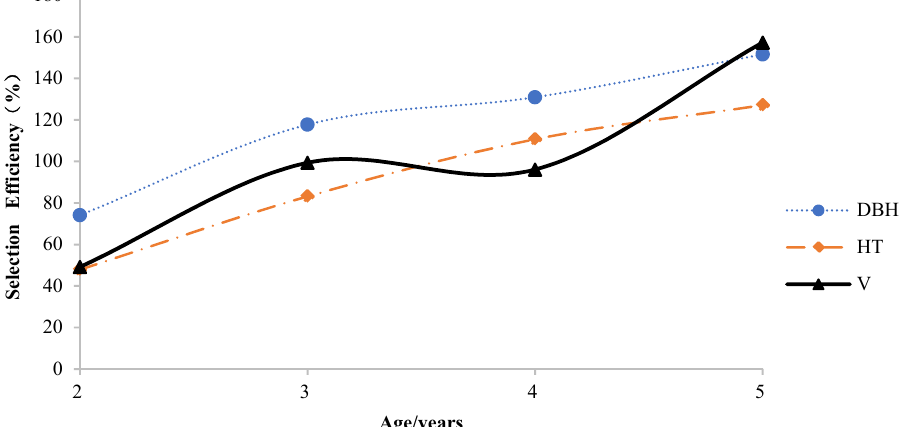
Figure 5. Selection efficiency for the three growth traits at various selection ages, taking growth traits at age 12 as the targets for improvement.